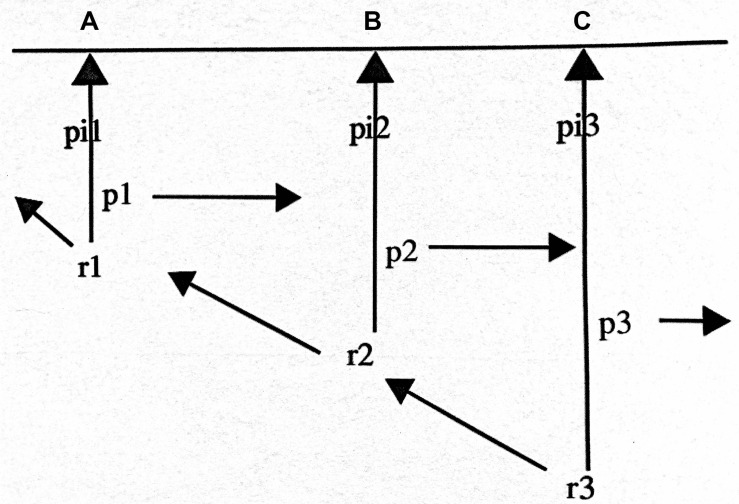
Husserl’s model of time consciousness, from Gallagher (1998, 2011) and Gallagher et al. (2017, p. 85).